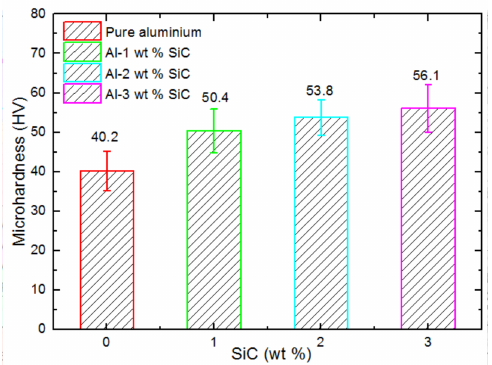
Figure 6. The microhardness of nanocomposite samples in different weight fractions of nano-SiC.